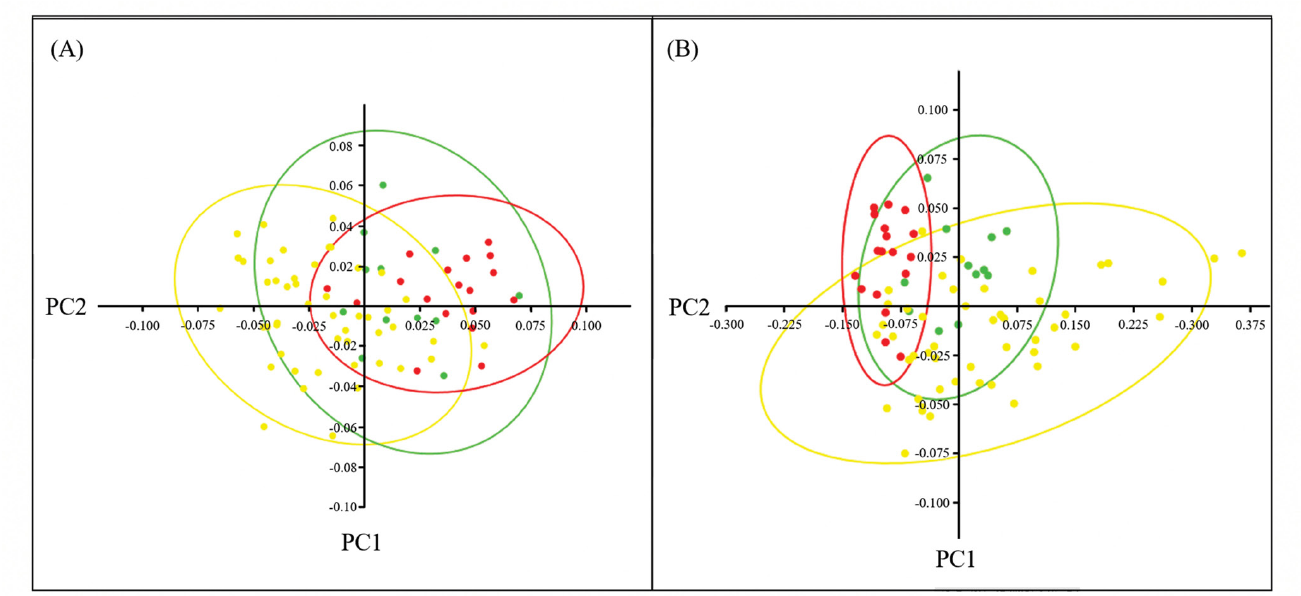
FIGURE 6 | Principal Component Analysis (PCA) for morphological data ( A ) disregarding the lip area; ( B ) considering the lip area. Gymnogeophagus lacustris is represented in red, G. labiatus HBT is represented in green and G. labiatus HBP is represented in